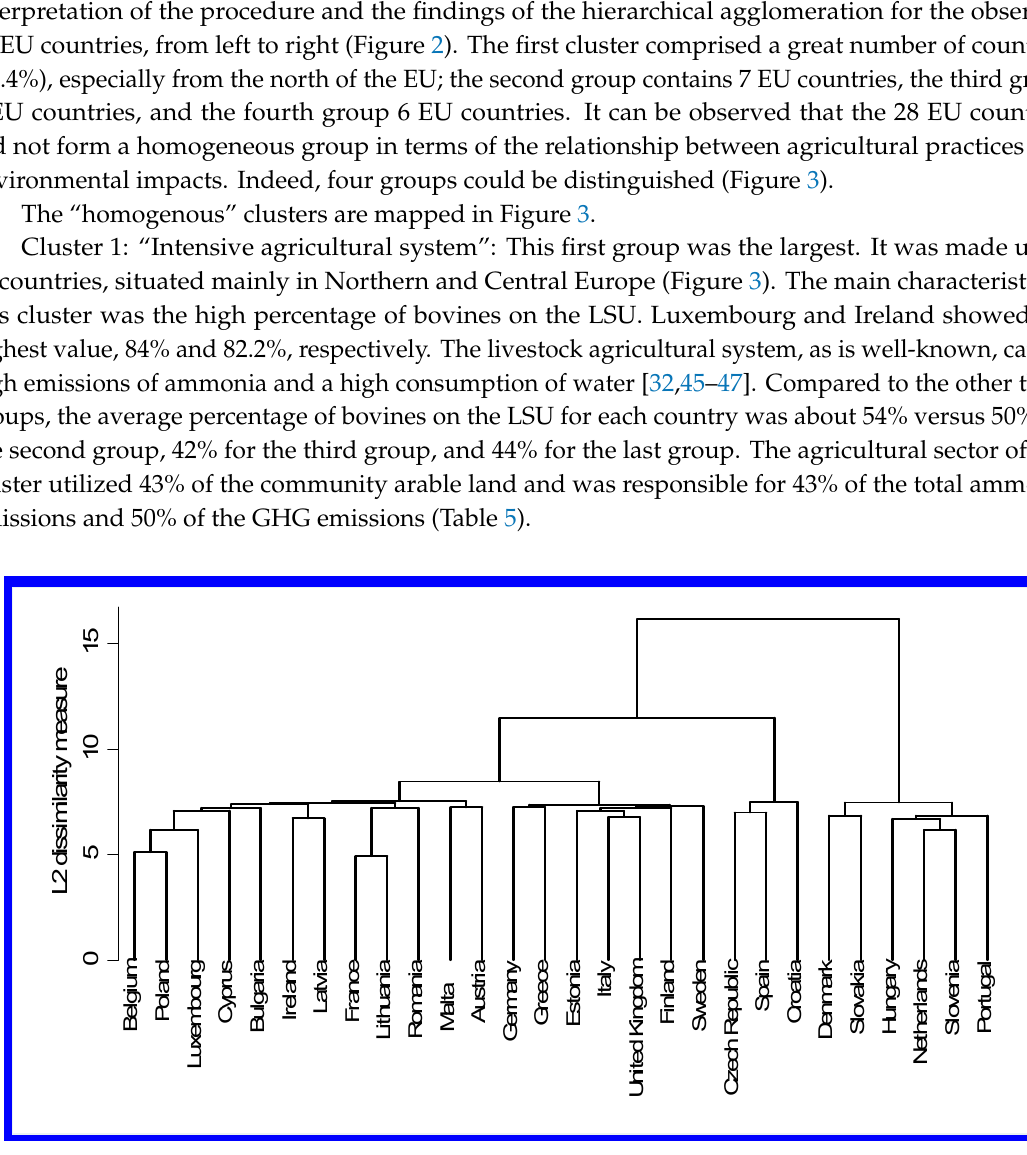
Figure 3. “Homogenous” European Union (EU) countries groups.